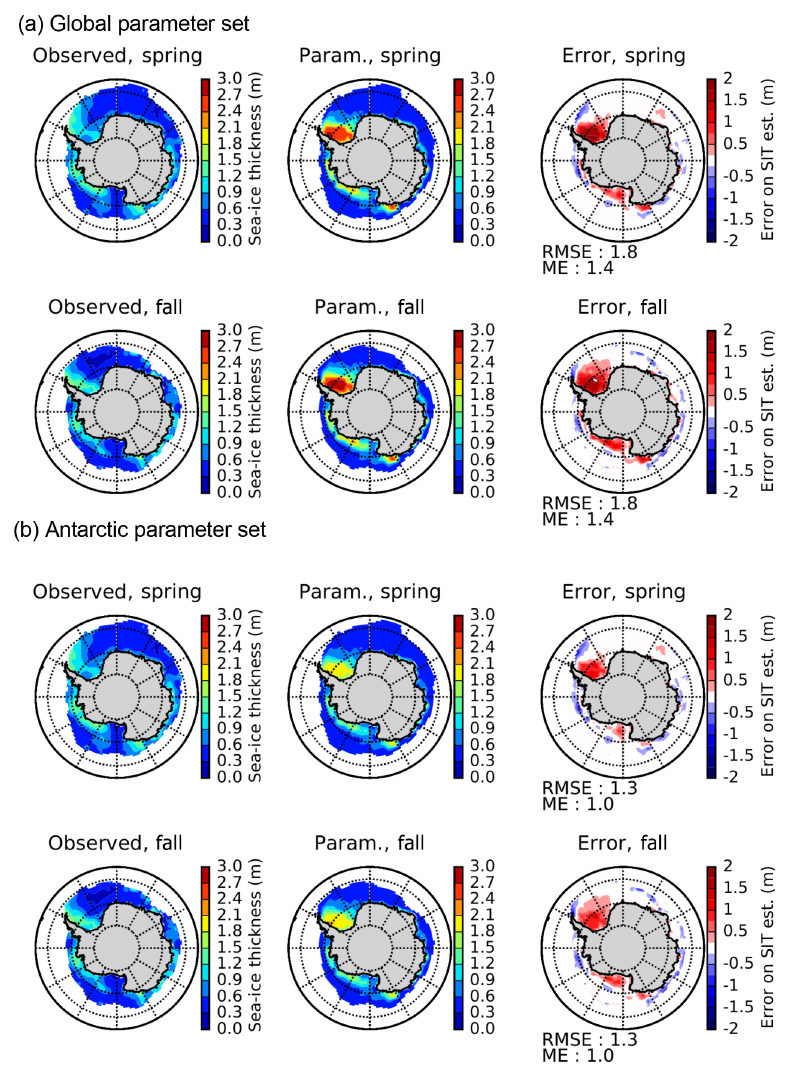
Figure 12. Observed Kurtz and Markus (2012) and parameterised Antarctic sea-ice thickness (in m) for spring and fall and the difference between these (right) with (a) the global parameter set and (b) the Antarctic-specific parameter